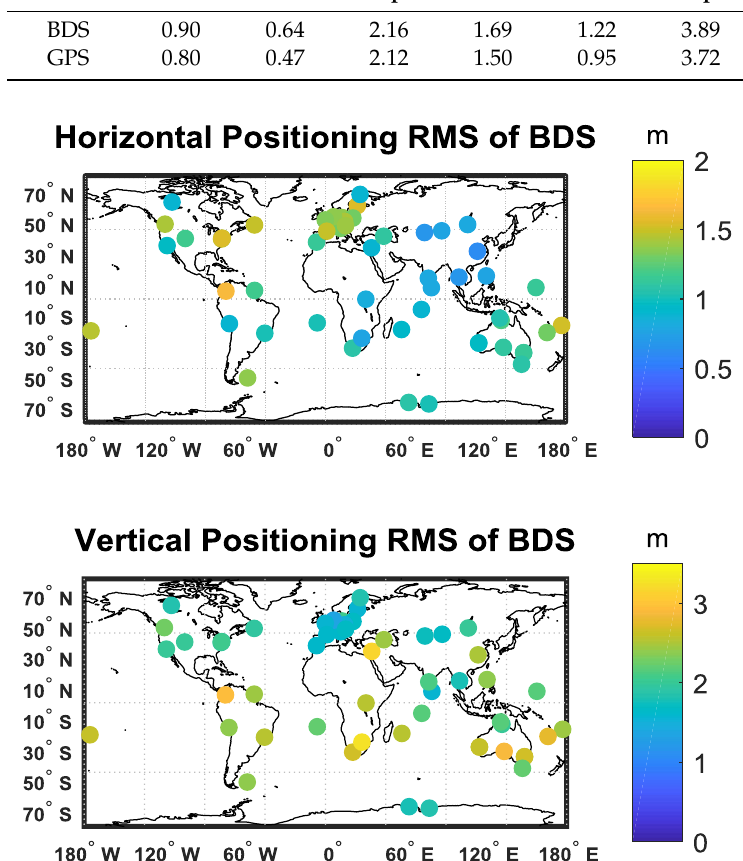
Figure 6. RMS of SPP performance in horizontal (upper) and vertical (lower) using current BDS constellation (54 stations, one week) .